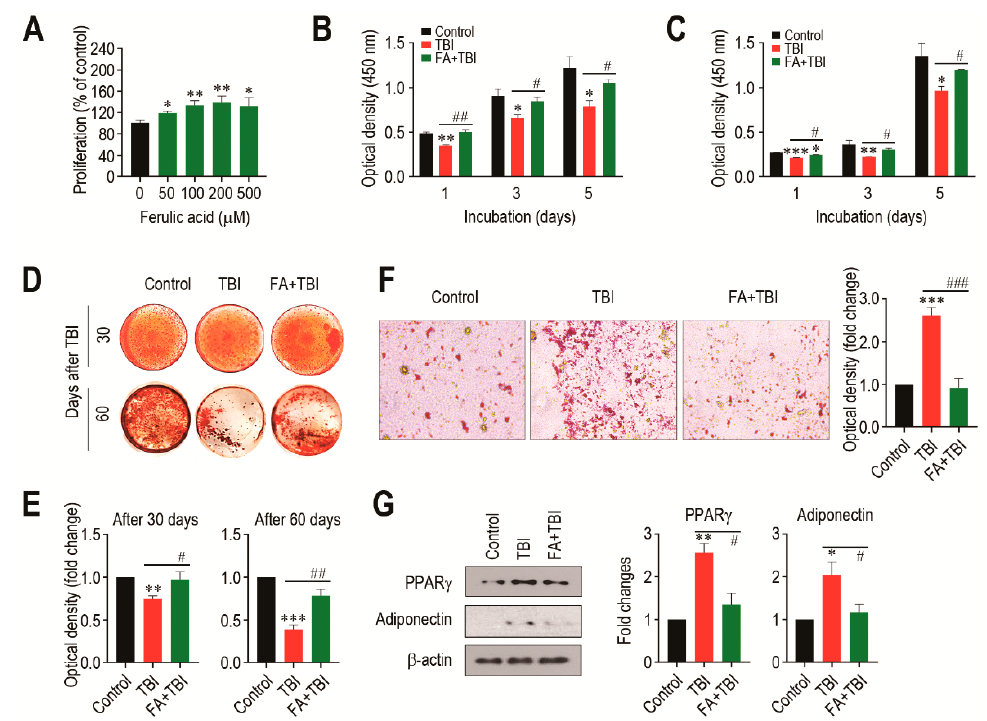
Figure 6. Supplemental ferulic acid restores proliferation and osteogenic differentiation of BMSCs and prevents adipogenic activation of the cells from TBI mice. ( A ) BMSCs isolated from non-TBI control mice were incubated in growth medium supplemented with ferulic acid (0–500 μ m) for 48 h, and proliferation rate was determined by CCK-8 assay. BMSCs were isolated from mice exposed to TBI or in combination with ferulic acid at ( B ) 30 and ( C ) 60 days post-TBI, and the cells were incubated in growth medium for the indicated days, followed by CCK-8 assay. ( D ) BMSCs were isolated from mice groups at 30 and 60 days post-TBI and incubated in osteogenic medium. After 21 days of incubation, cellular mineralization of the cells was evaluated by ARS staining. ( E ) Mineralization of BMSCs from mice groups was also determined by measuring optical density specific to the ARS at 405 nm. ( F ) BMSCs were isolated from mice groups 30 days after TBI and incubated in adipogenic medium. The photographs showing ORO-positive adipocytes and optical density specific to the dye were obtained 21 days after incubation. ( G ) BM cells were isolated from mice groups 7 days after TBI and, after 48 h of incubation in adipogenic medium, protein levels of PPAR γ and adiponectin in the cells were determined by immunoblot assay. The relative intensities specific to PPAR γ and adiponectin were determined after normalizing the band to the relative intensity of β -actin. All data are presented as the mean ± SD ( n ≥ 3). * p < 0.05, ** p < 0.01, and *** p < 0.001 compared with control group; # p < 0.05, ## p < 0.01, and ### p < 0.001 compared with TBI